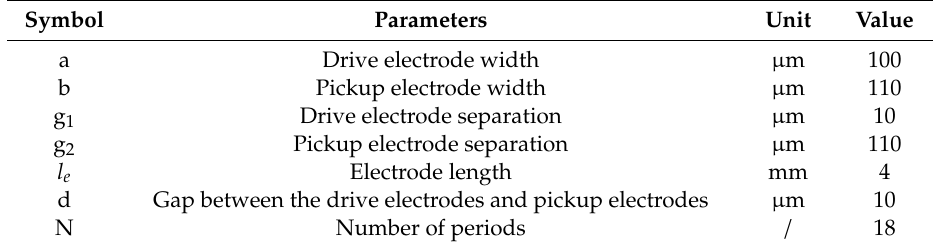
Table 3. Design parameters of the periodic array area-variation capacitive displacement transducer.